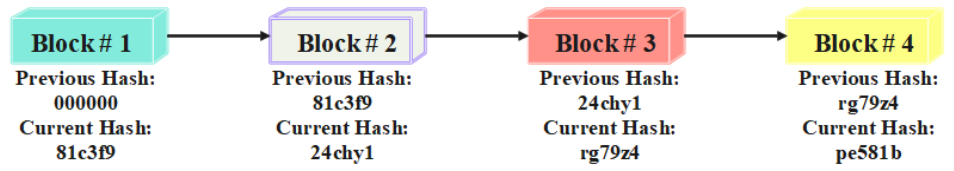
Figure 5. Connection of WSN nodes in the blockchain.